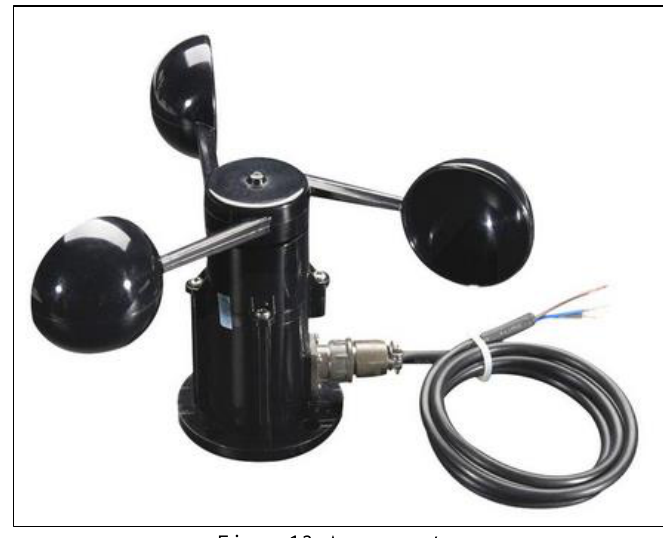
Figure 13: Anemometer. Source: Taken from